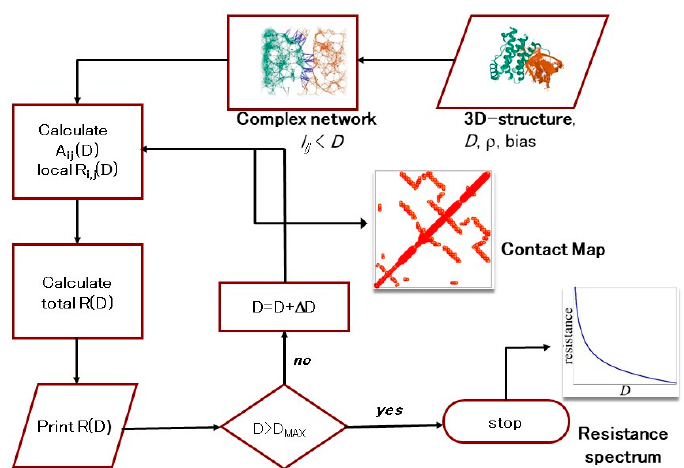
Figure 1. Flow chart of the computational procedure giving the resistance spectra and the contact maps. Starting from the 3D structure of the biomolecule and assigning a set of input parameters (D, ρ , bias), the equivalent complex network is built up. The adjacency matrix A is generated, and the contact map ensues. Local resistances are calculated, according to Equation (1), and from them we obtain the resistance of the whole network. The process is iterated over a large range of D values. Finally, the resistance spectrum is